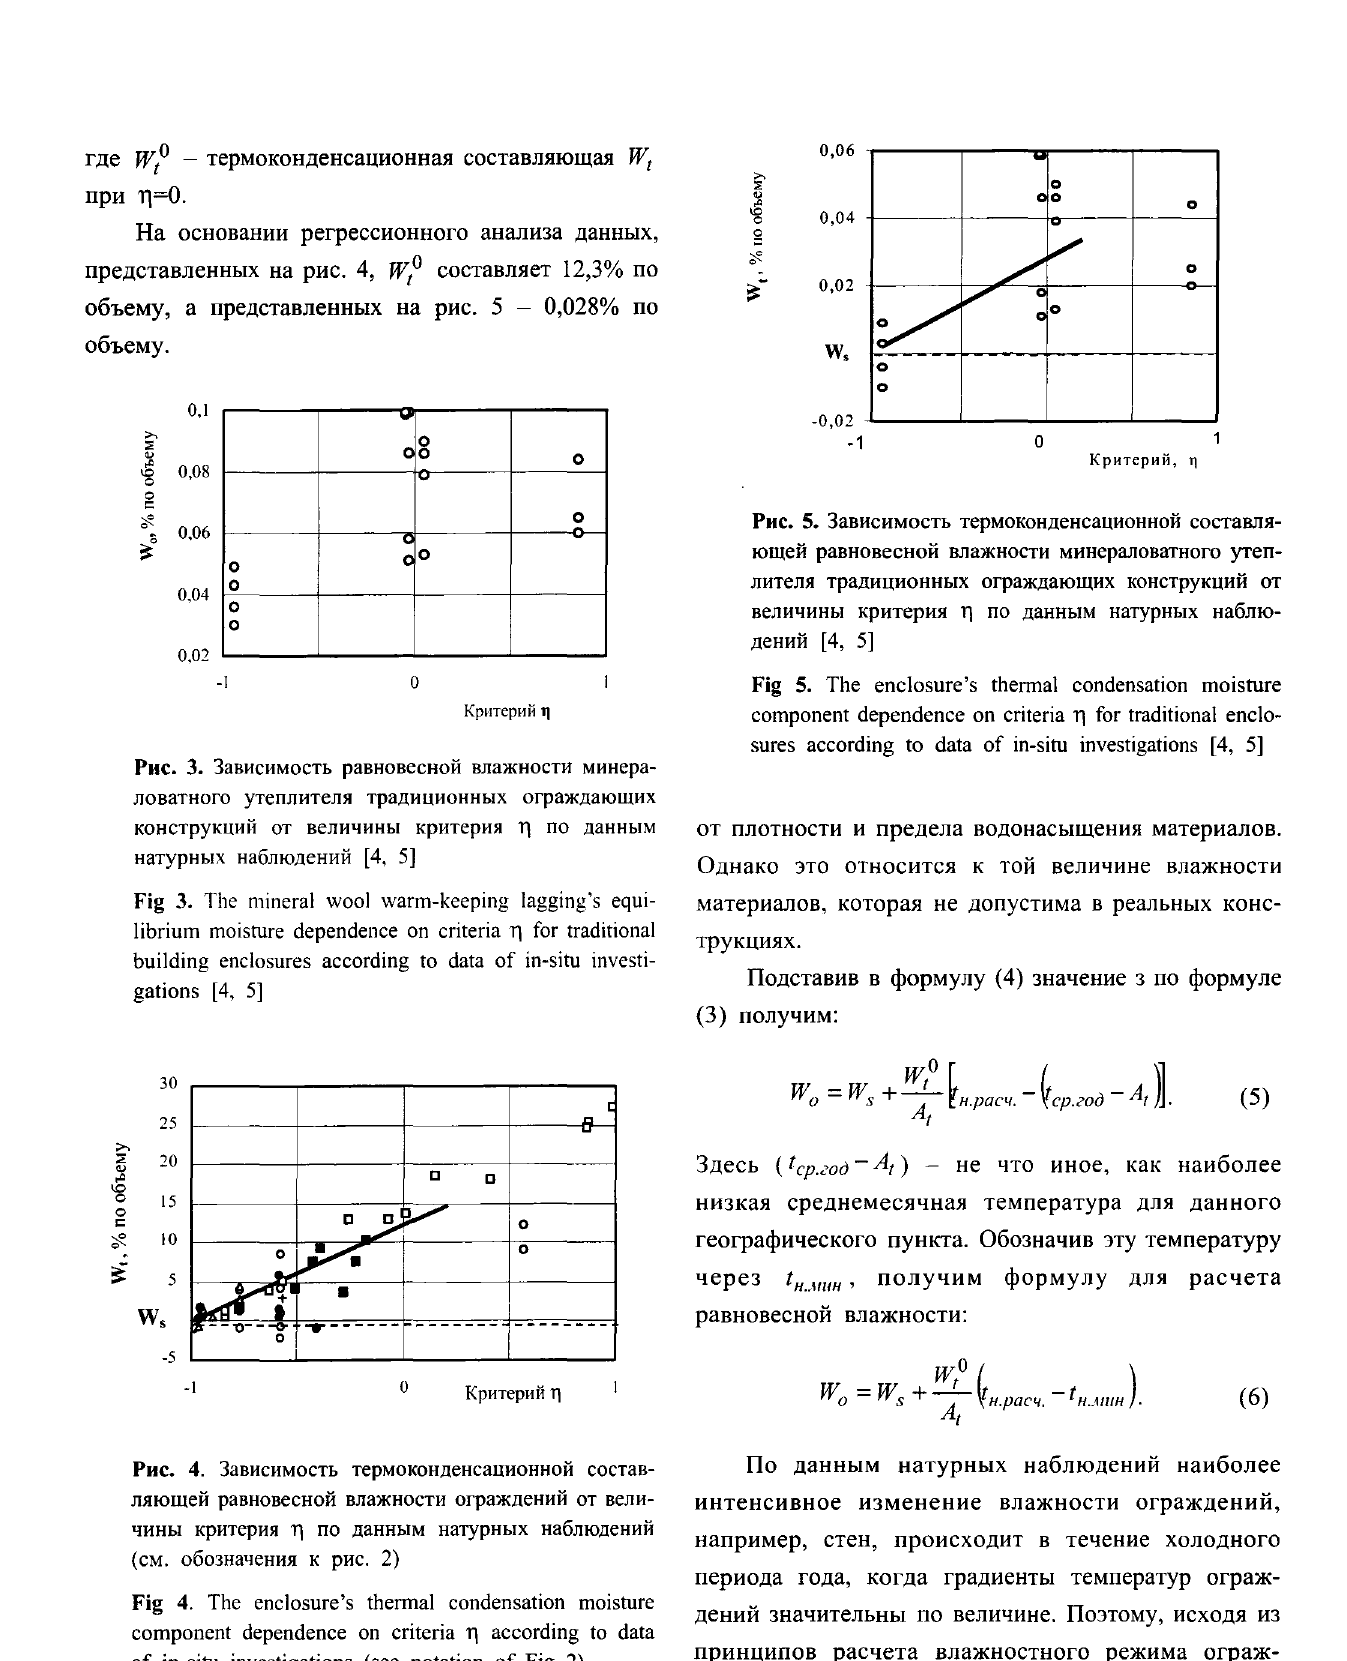
Fig 4. The enclosure's thermal condensation moisture component dependence on criteria 11 according to data of in-situ investigations (see notation of Fig 2)